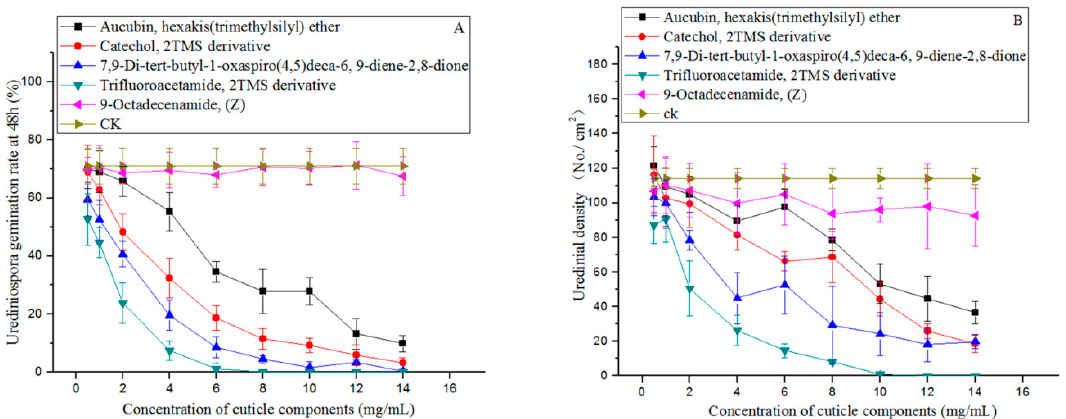
Figure 5. The effects of candidate compounds on the urediniospore germination and the number of pustules per square centimeter on leaves of P. purdomii . ( A ): The germination rate of urediniospores incubated in different cuticle components at 48 h. ( B ): Uredinial density on the leaves 11 days after inoculation with Melampsora larici-populina . The values represent the means of the replicates. The error bars represent the standard error of the means (n = 5).